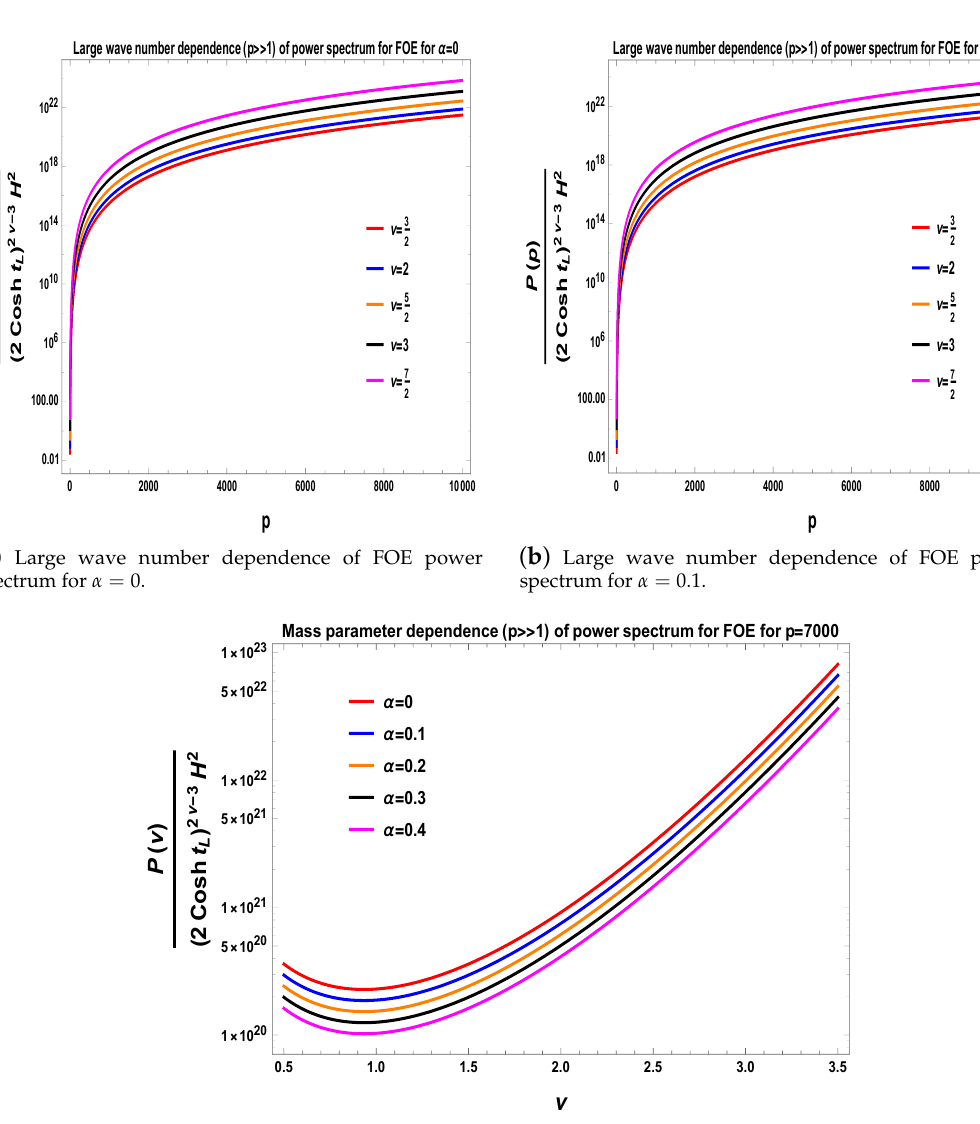
Figure 6. Features of FOE power spectrum in large wave number region. ( a ) Large wave number dependence of FOE power spectrum for α = 0; ( b ) Large wave number dependence of FOE power spectrum for α = 0.1; ( c ) Mass parameter dependence of FOE power spectrum for p >>